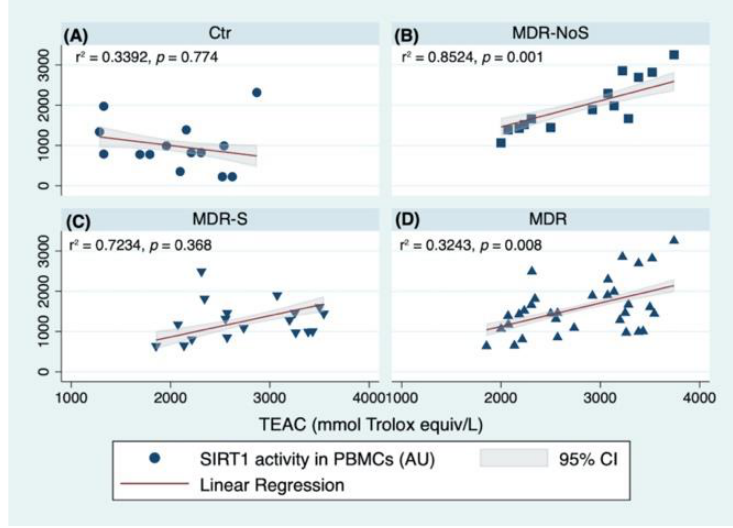
Figure 4. Linear regression analyses with SIRT1 (SIRT1) activity measured in peripheral blood mononuclear cells (PBMCs) and Trolox equivalent antioxidant capacity (TEAC) measured in serum of CTR ( A ), MDR-NoS ( B ), MDR-S ( C ), and MDR ( D ). The groups were: sedentary controls (CTR), middle distance runners (MDR) not taking antioxidant supplements (MDR-NoS), and MDR taking antioxidant supplements (MDR-S), indicated, respectively, with a black circle, black square, black triangle with the vertex at the bottom, and black triangle with the vertex at the top. All data are expressed as mean ± SD.